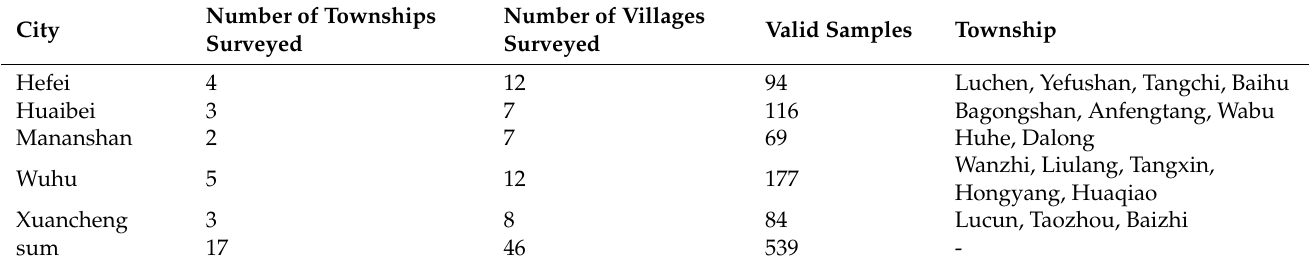
Table 1. Description of samples.